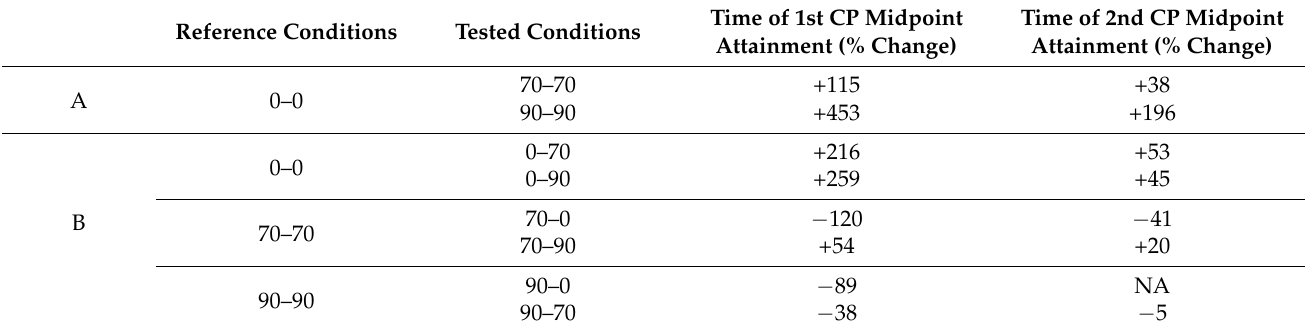
Table 2. The effect of D 2 O on growth and cell division (section A), or specifically on cell division (section B) in C. reinhardtii . The effects are expressed as the proportional (%) change in the time required to attain the first or second commitment points (CP) in comparison with respective reference conditions. Both reference and tested conditions are described as in Table 1, i.e., 0–70 represents sample grown in media with 0% D 2 O, which was transferred to the dark to 70% D 2 O, etc. NA = effect not analyzed, as the CP was not attained by more than 30% of the